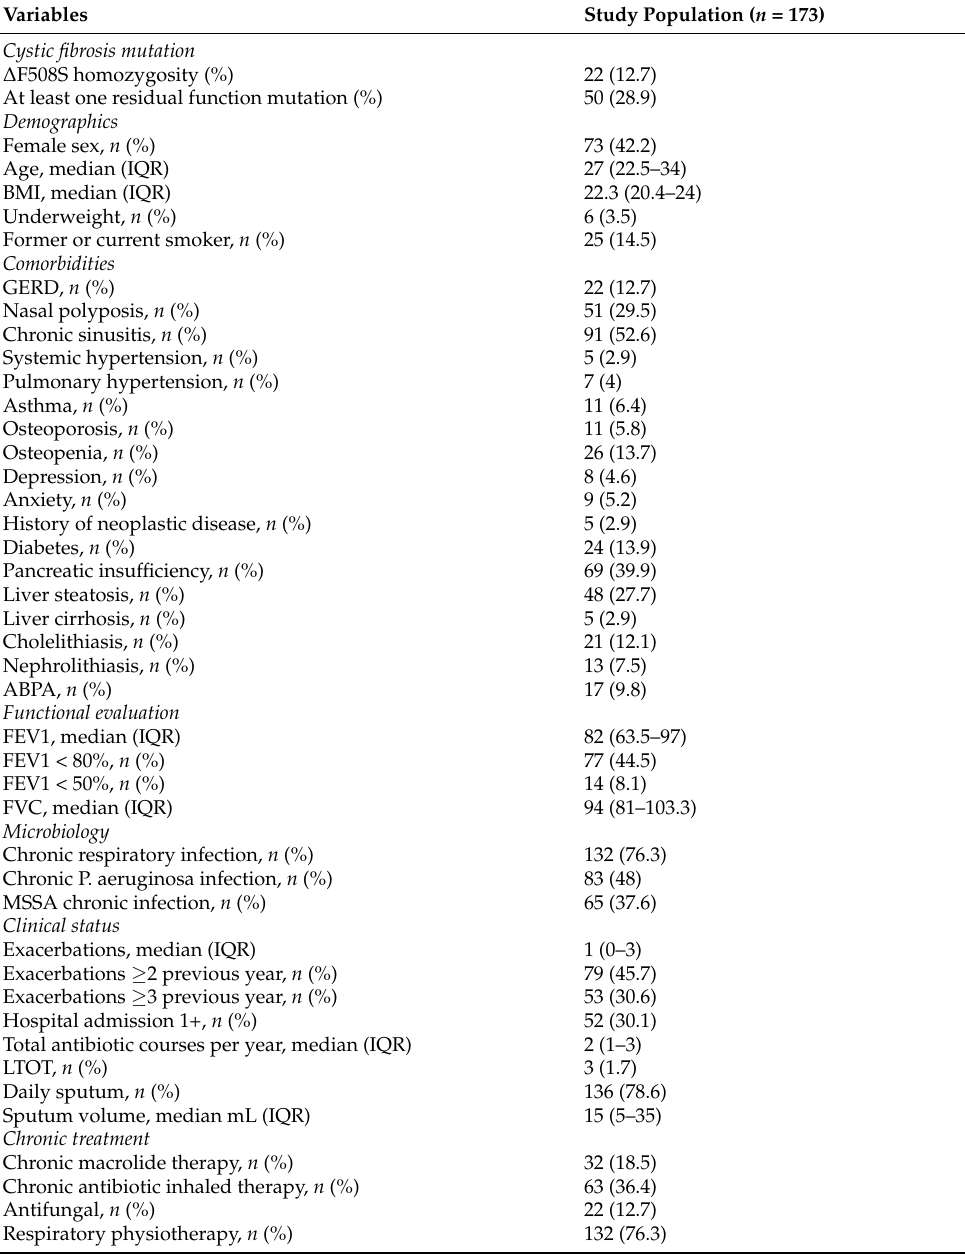
Table 1. Demographics, clinical, functional and microbiological characteristics of the study